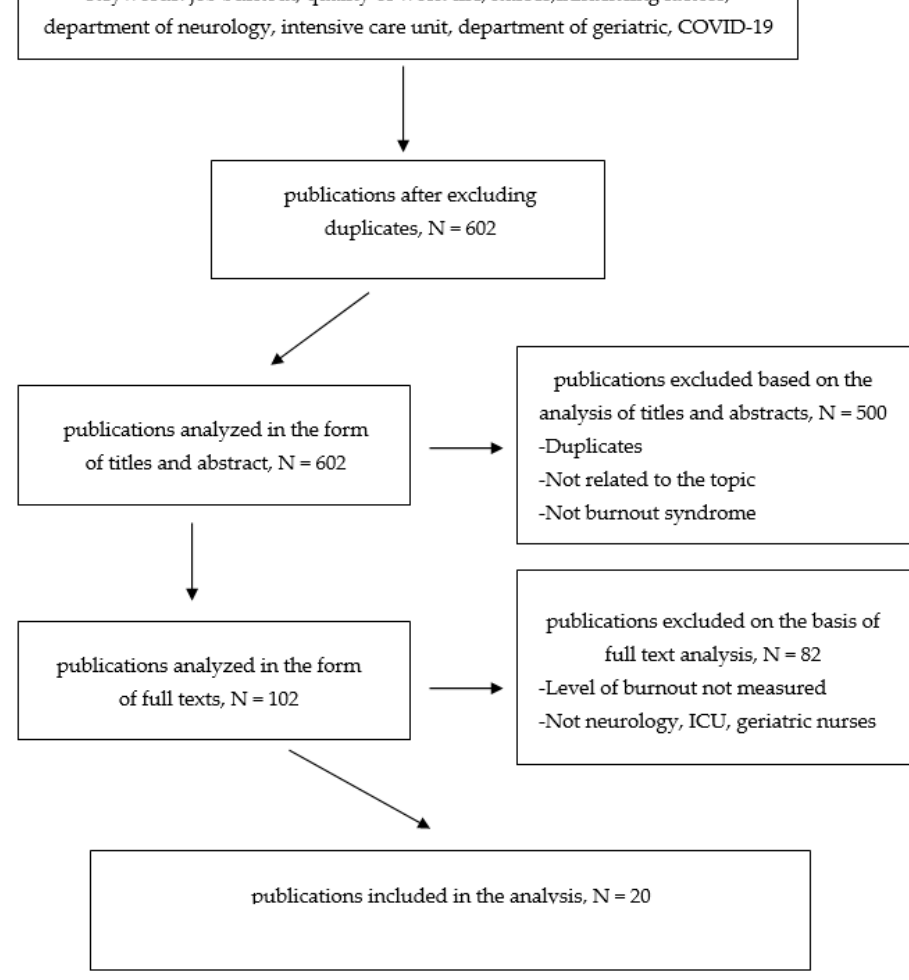
Figure 1. Pathways diagram of the literature search strategy.